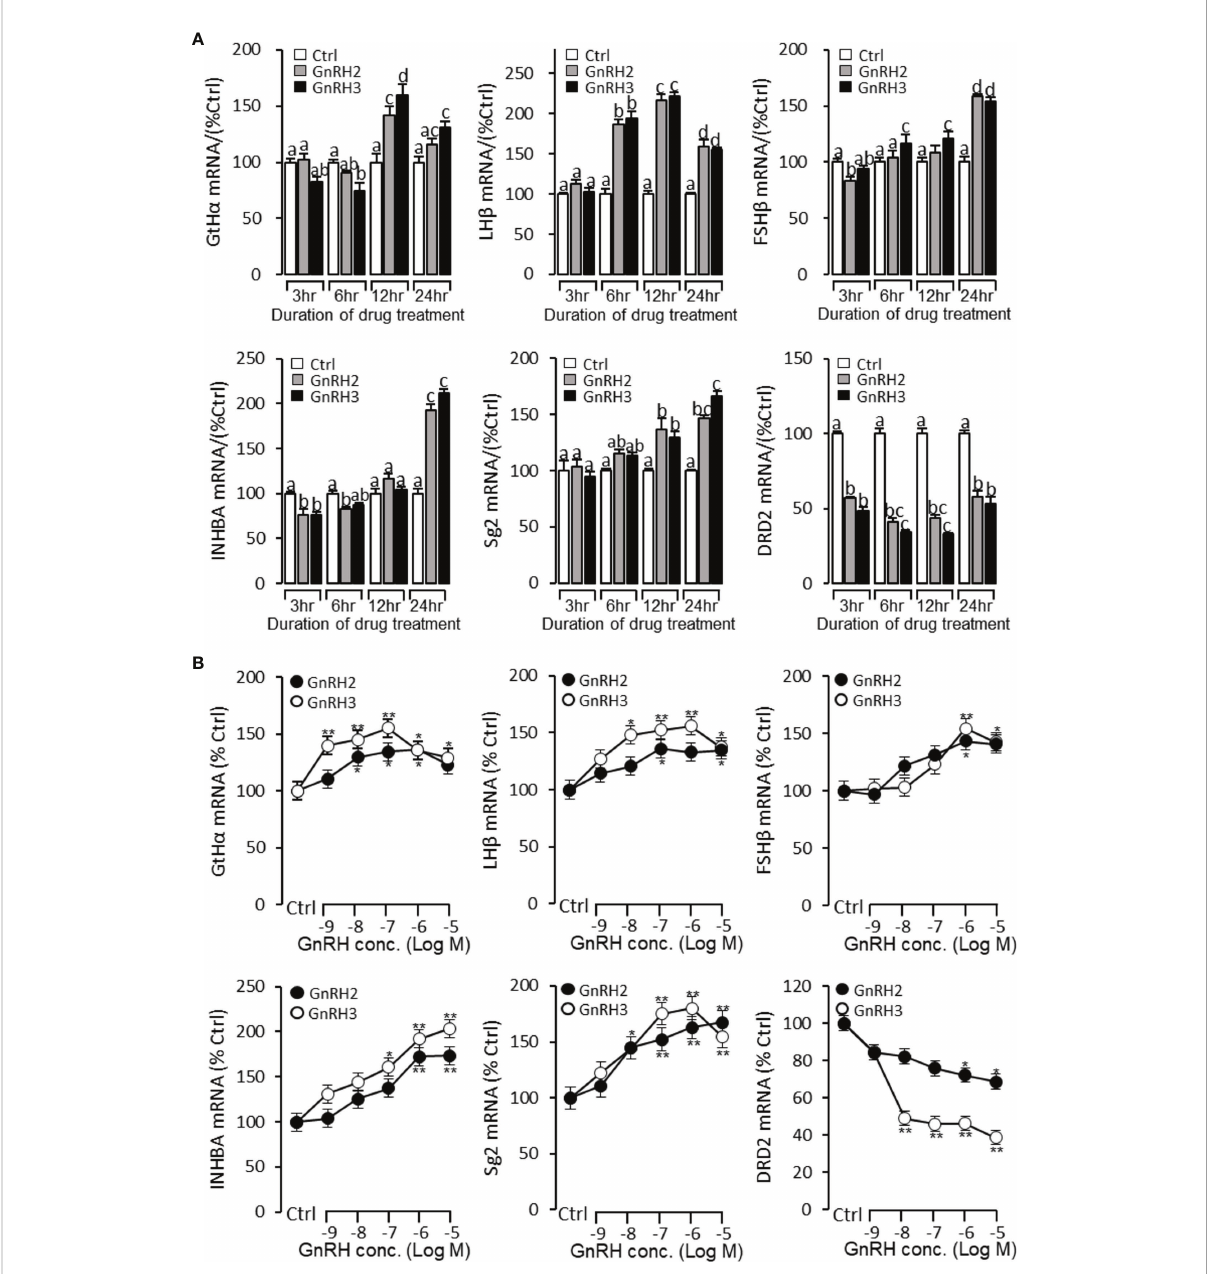
FIGURE 5 Regulation of reproductive hormone gene mRNA expression by GnRH2 and GnRH3 in grass carp pituitary cells. (A) Time-course experiment of grass carp GnRH2 (1 m M) and GnRH3 (1 m M) on GtH a , LH b , FSH b , INHBa, SgII, and DRD2 mRNA expression in grass carp pituitary cells. (B) Dose dependence of a 24-h treatment with increasing levels of GnRH2 and GnRH3 (0.1 – 1,000 nM) on GtH a , LH b , FSH b , INHBa, SgII, and DRD2 mRNA expression in grass carp pituitary cells. After drug treatment, the pituitary cells were extracted to total RNA, reversed transcribed, and used for RT-PCR to detect the target genes ’ mRNA expression. Data presented are expressed as mean ± SEM. p < 0.05 ( “ * ” ) or p < 0.01 ( “ ** ” ) was used to present signi fi cant differences among each group. The different letters represent a signi fi cant difference at p < 0.05 between groups (ANOVA followed by a Dunnett